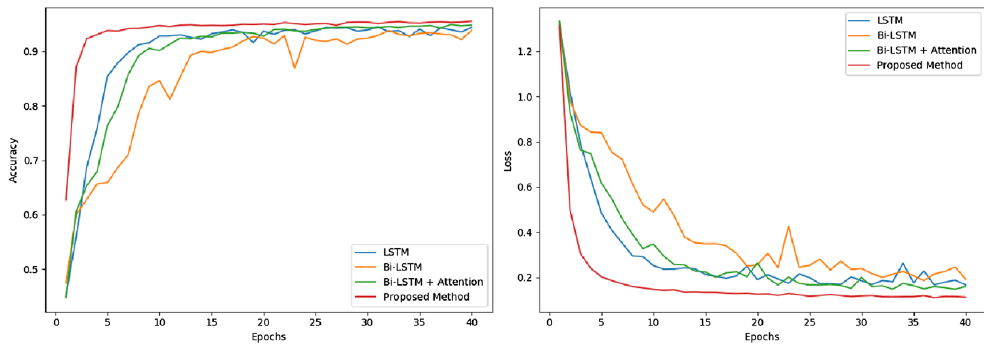
Figure 8. The accuracy and loss comparation of different models on validation set.